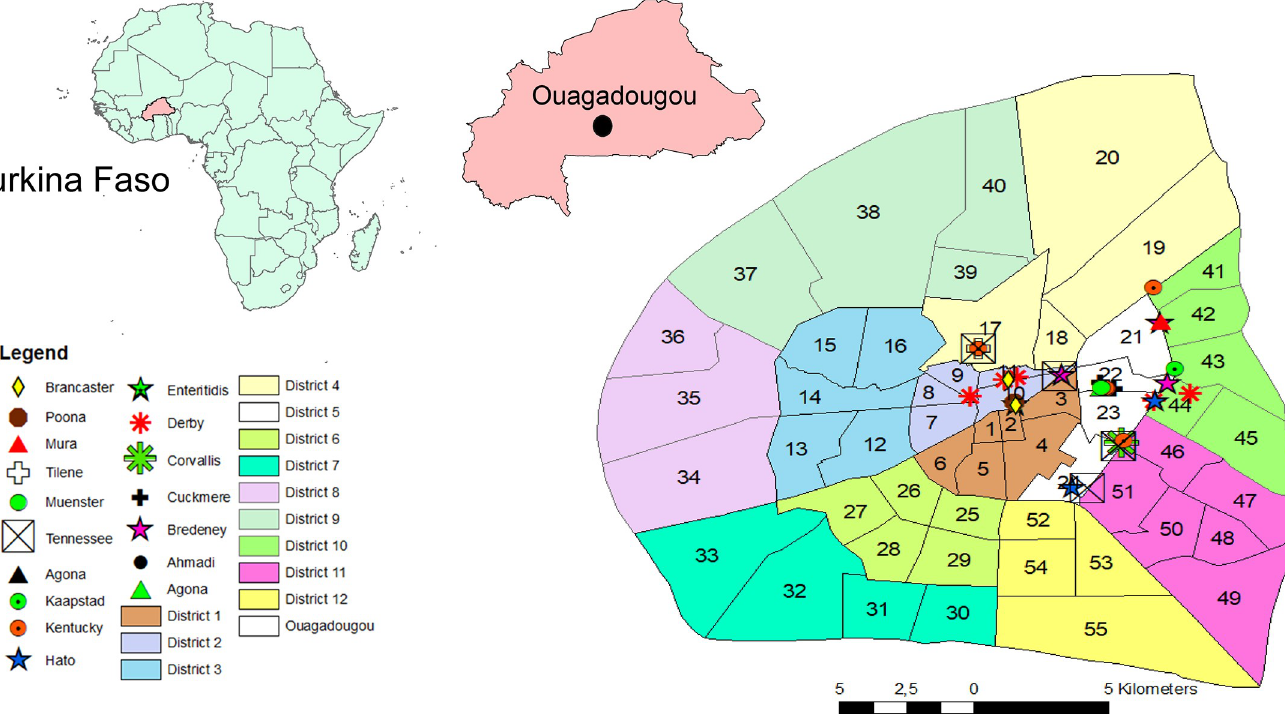
PLOS ONE | https://doi.org/10.1371/journal.pone.0253312 June 17,